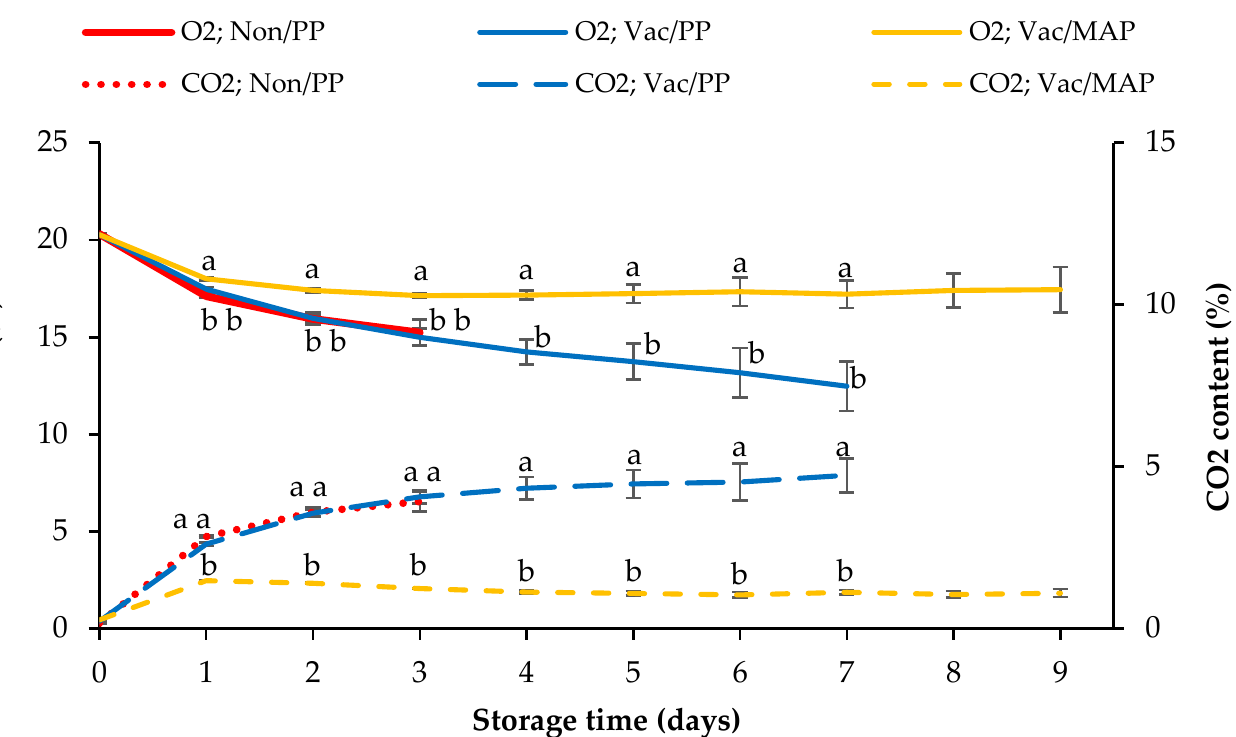
Figure 4. Changes in head space gas content of the whole packaged fresh-cut vegetables during storage at 4 °C. Error bars represent the mean of three replicates ± SD.